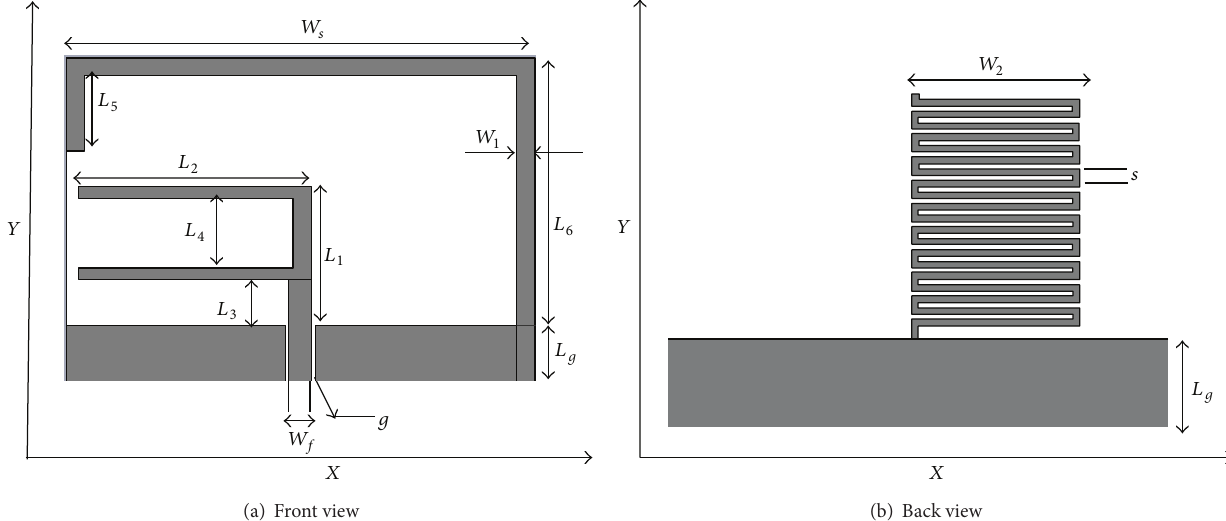
Figure 1: Geometry of the proposed antenna: (a) front view and (b) back view.